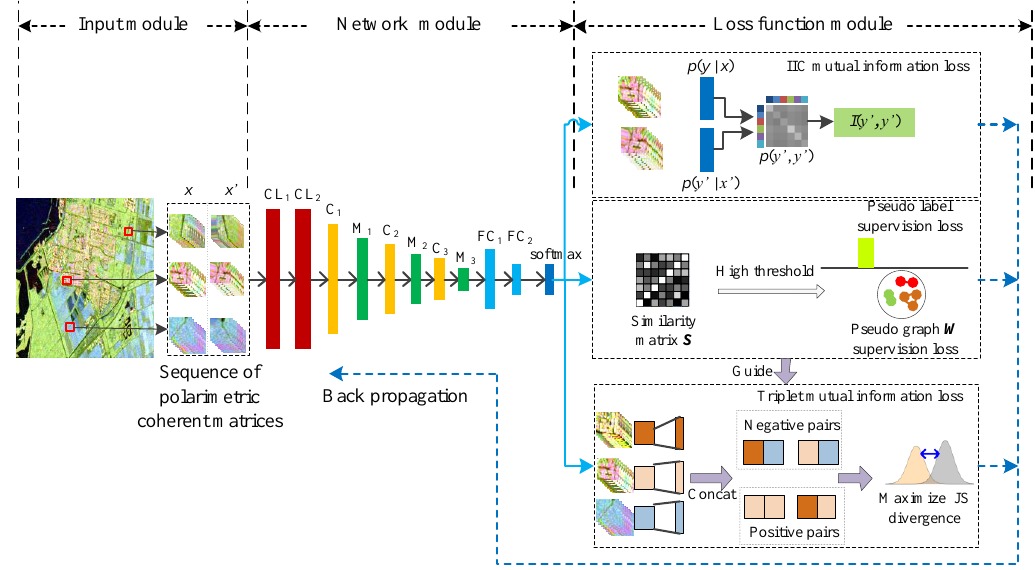
Figure 1. The architecture of proposed method. It consists of three modules: the first one is the input module, the second one is the network module and the latter one is the loss function module. The paired sequences of polarimetric coherent matrices of each pixel’s neighborhood window, for example the three red boxes in the input module, are the inputs of the network module. The network module is stacked by some deep learning layers, such as Convolutional Long Short Term Memory (ConvLSTM) (CL) layers, Convolutional (C) layers, and so on. The loss function module is used for network back